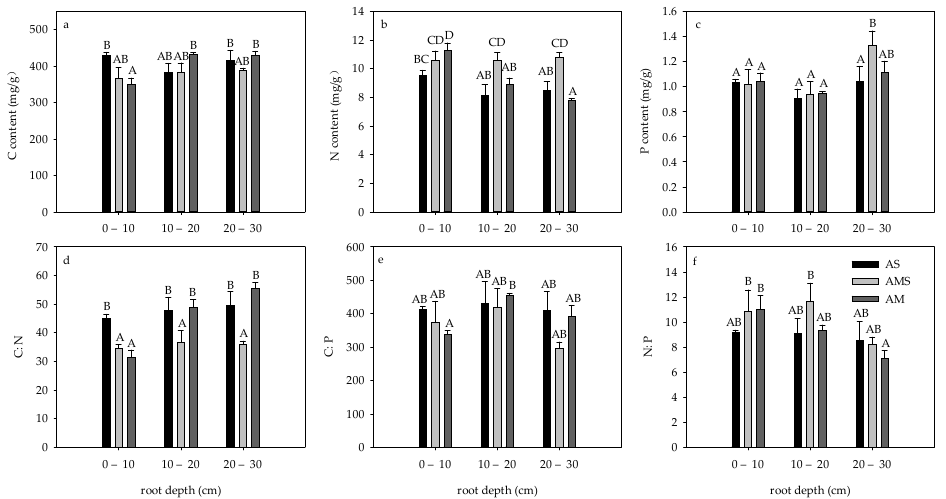
Figure 1. Root carbon, nitrogen, phosphorus, C:N, C:P, and N:P in April. ( a ) Root C content; ( b ) Root N content; ( c ) Root P content; ( d ) Root C:N; ( e ) Root C:P; ( f ) Root N:P. Different letters correspond to statistical differences at 0.05